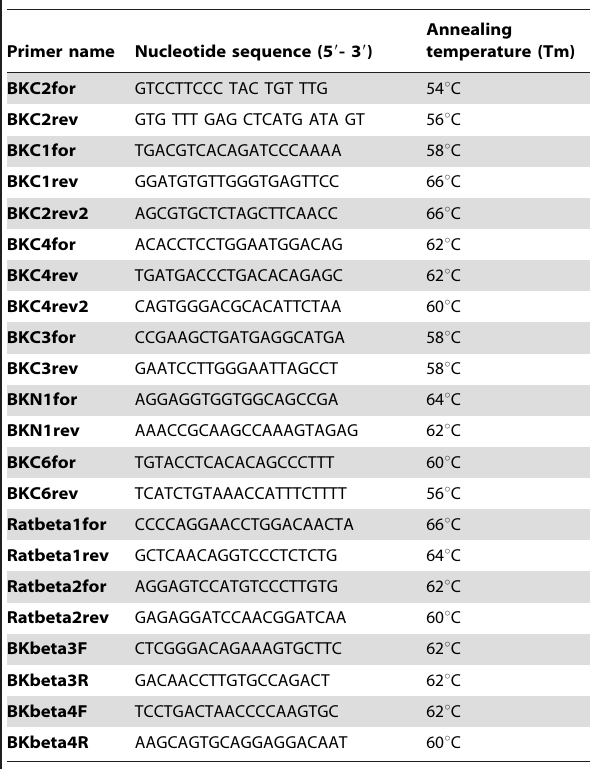
Table 2. Primers used for PCR